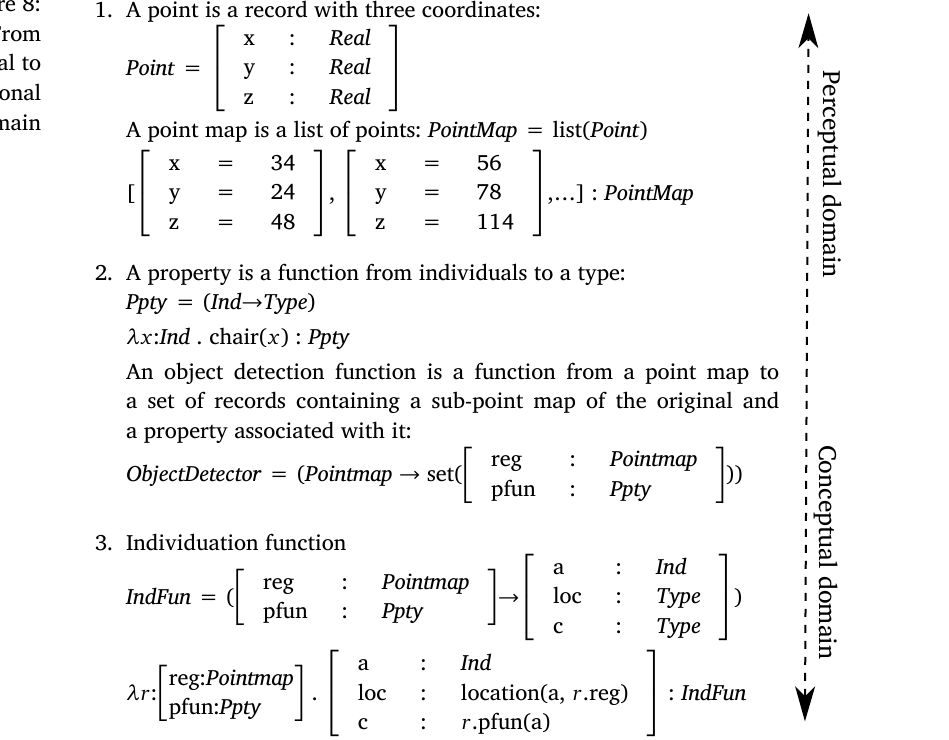
Figure 8: From perceptional to